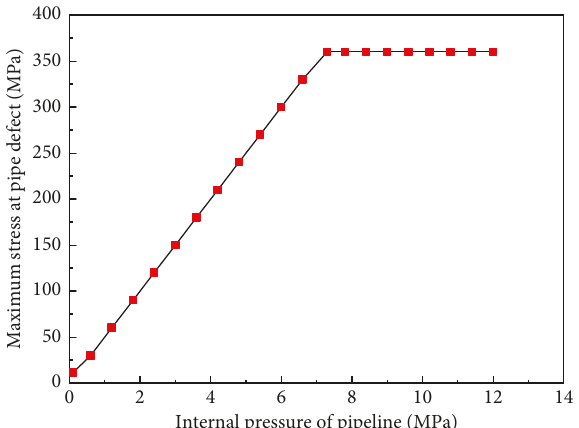
Figure 9: Relationship between internal pressure and maximum stress of the defective pipeline.